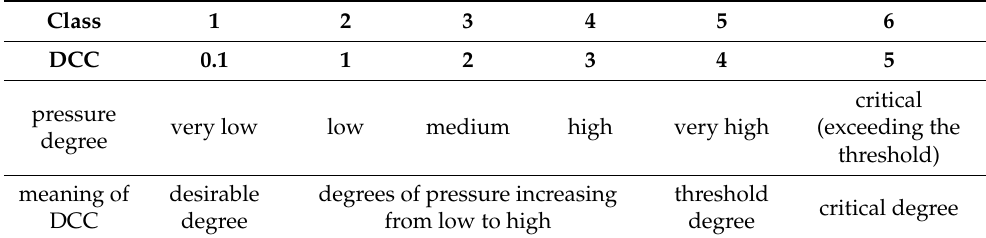
Table 2. DCC classes and their